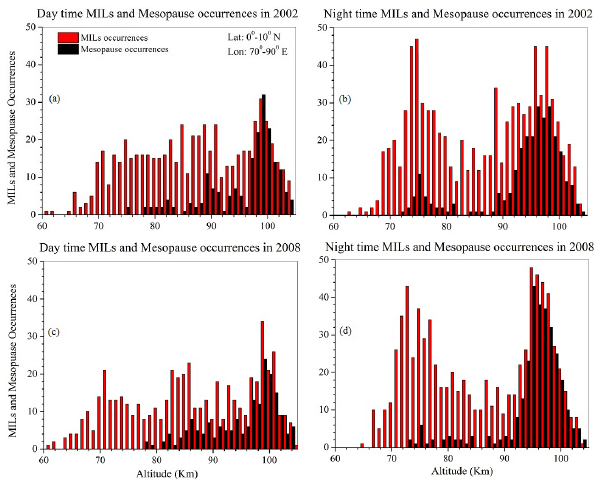
Figure 3. Altitude distribution of MILs and mesopause occurrences during March, June, September and December months for the day- time measurements of year 2008 revealing the seasonal